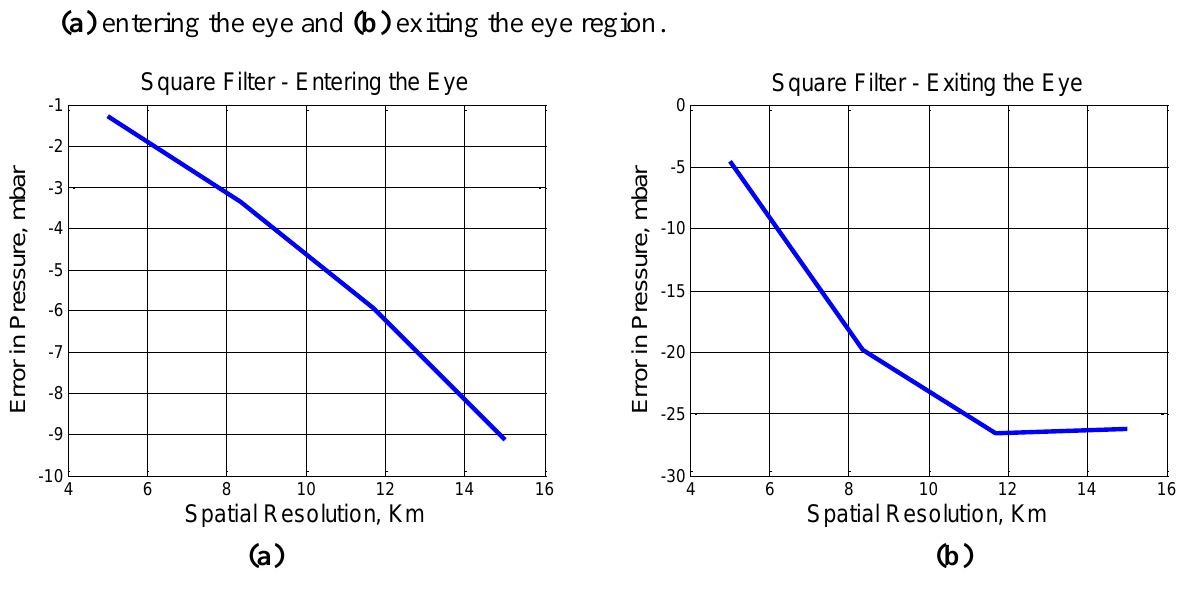
Figure 4. Error in the pressure depression estimate as a function of spatial resolution